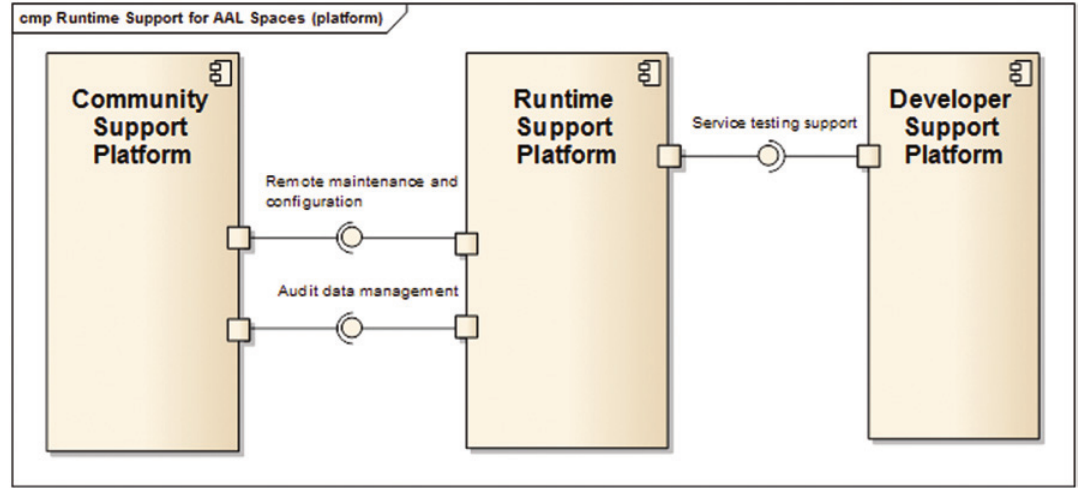
Figure 4: Platform-to-Platform Services Provided by the Runtime Support Platform.